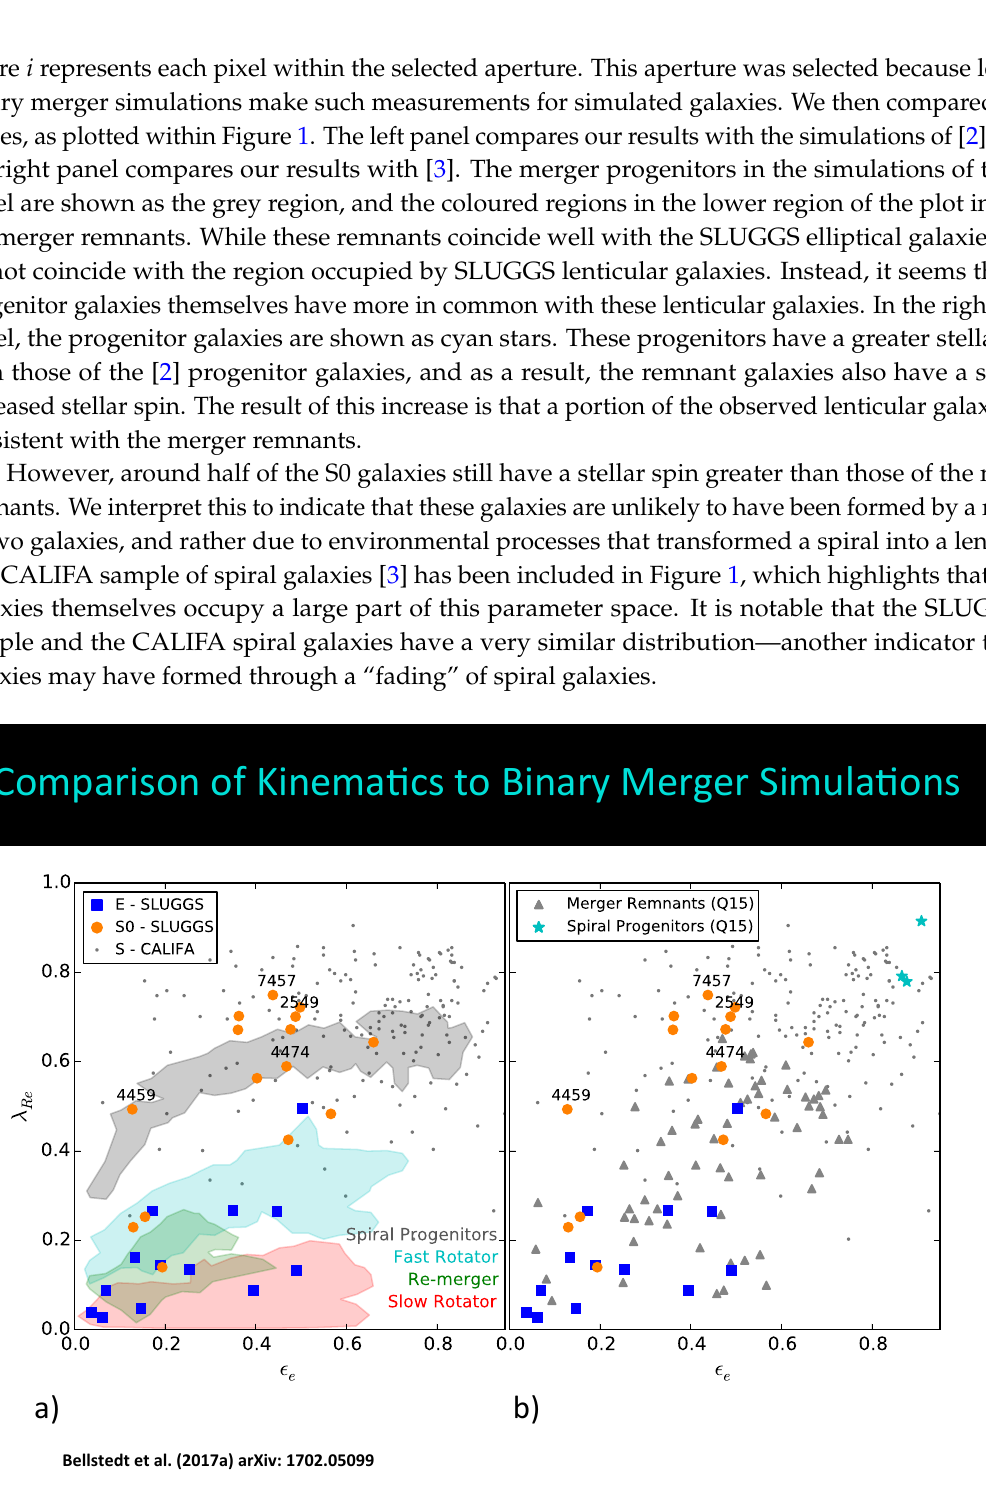
Figure 1. Stellar spin against ellipticity for SLUGGS galaxies, compared with results from two different binary merger simulations. ( a ) Comparing with the simulations of [2]. Grey shaded region shows the distribution of merger progenitors, while the other shaded regions indicate the different types of remnants produced by the simulations. ( b ) Comparison with the simulations of [3]. Cyan stars depict the merger progenitors, while grey triangles represent merger